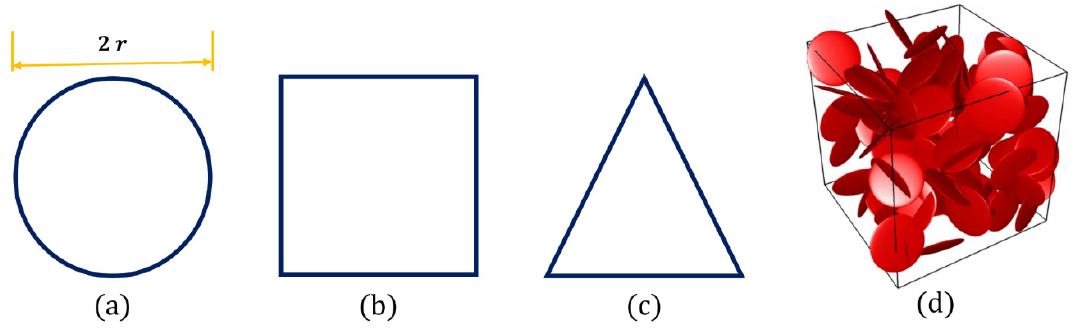
Figure 9. Three fundamental geometries of plates ( a – c ), and computer realization of one hundred circular plates in 3D space ( d ) [34]. Table 1. Estimated percolation points ( η c ) for di ff erent geometries in 3D space [34].